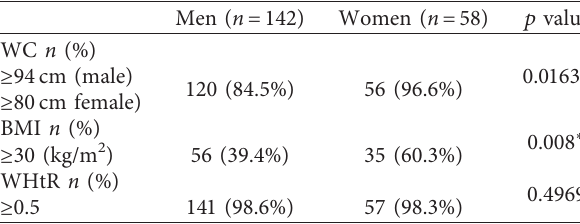
Table 2: Abnormal values of study variables in males and